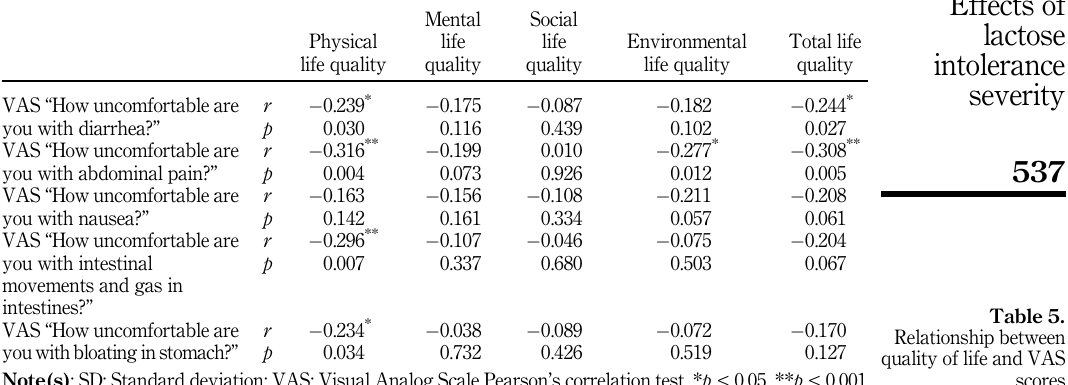
Table 5. Relationship between quality of life and VAS